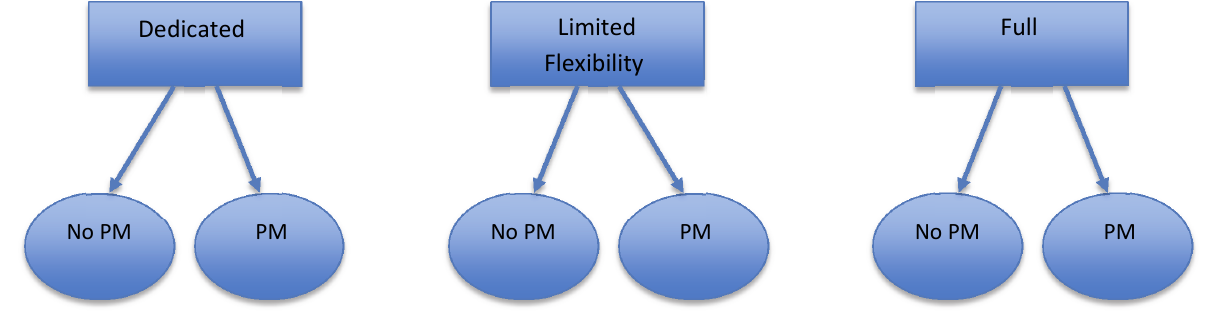
Fig. 2. Simulation